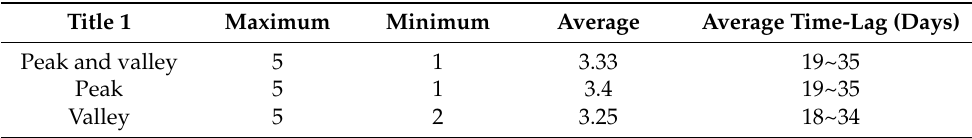
Table 2. Statistics of difference between peak/valley.